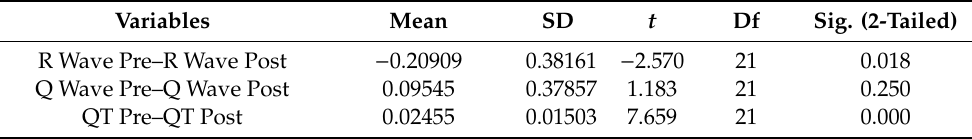
Table 6. Paired t -test comparison of pre-and post-exercise electrocardiographic variables. Variables